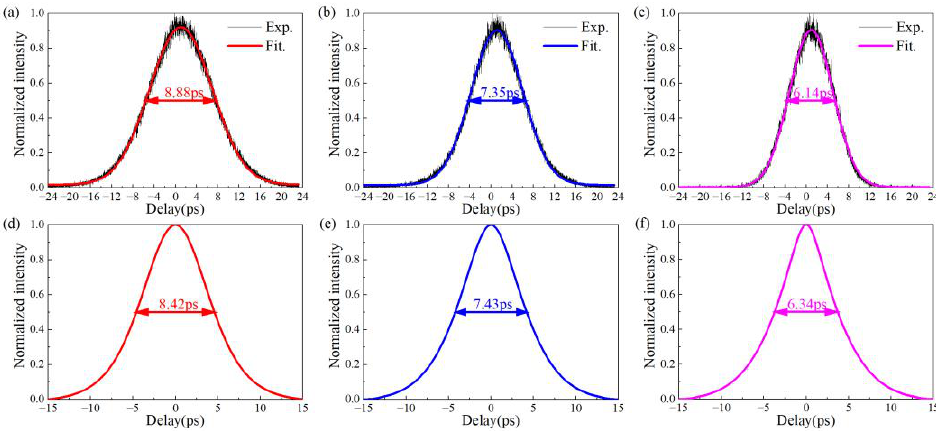
Figure 12. Compared output pulse duration of ( a – c ) experiment and ( d – f ) simulation based on the same input pulse parameters.